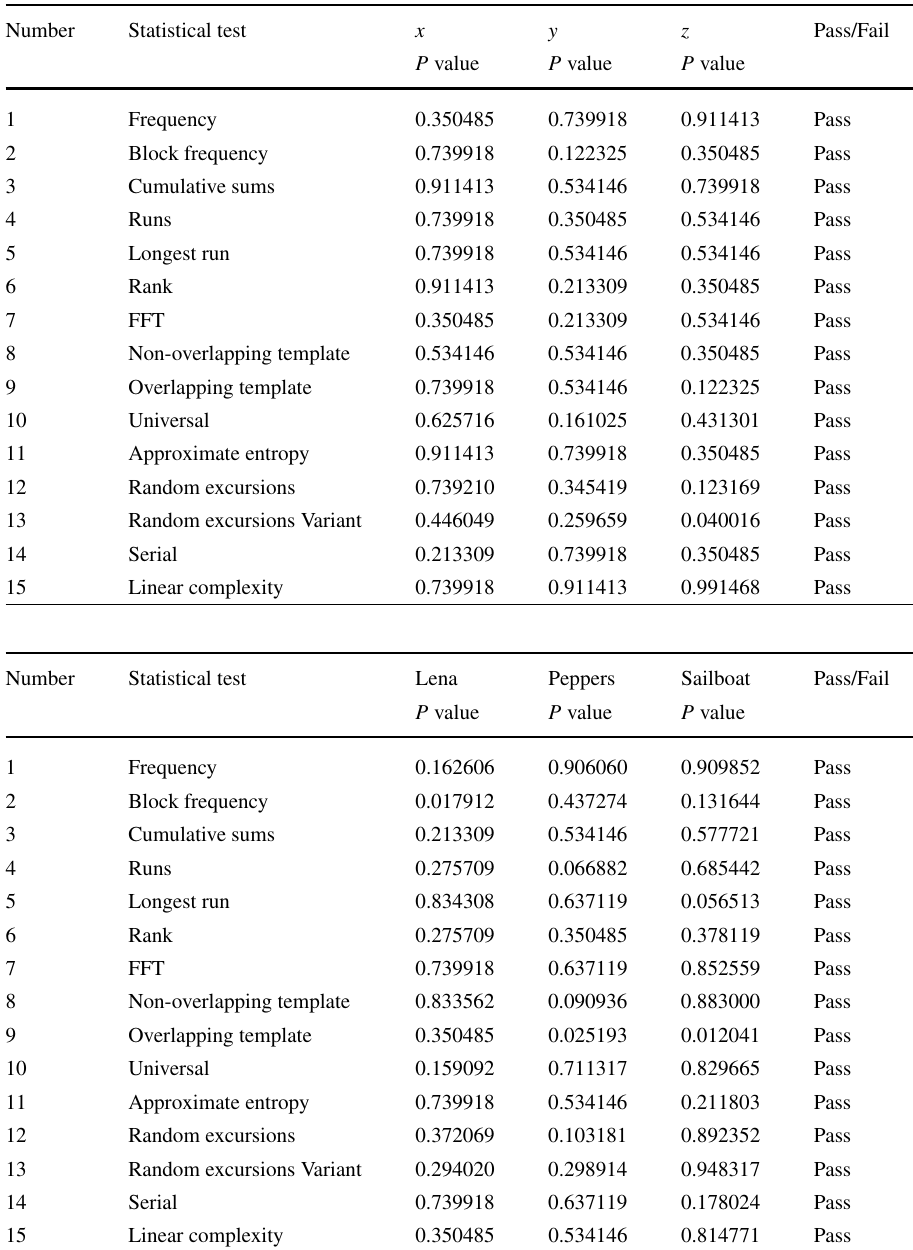
Table 13 NIST analyses for chaotic sequences